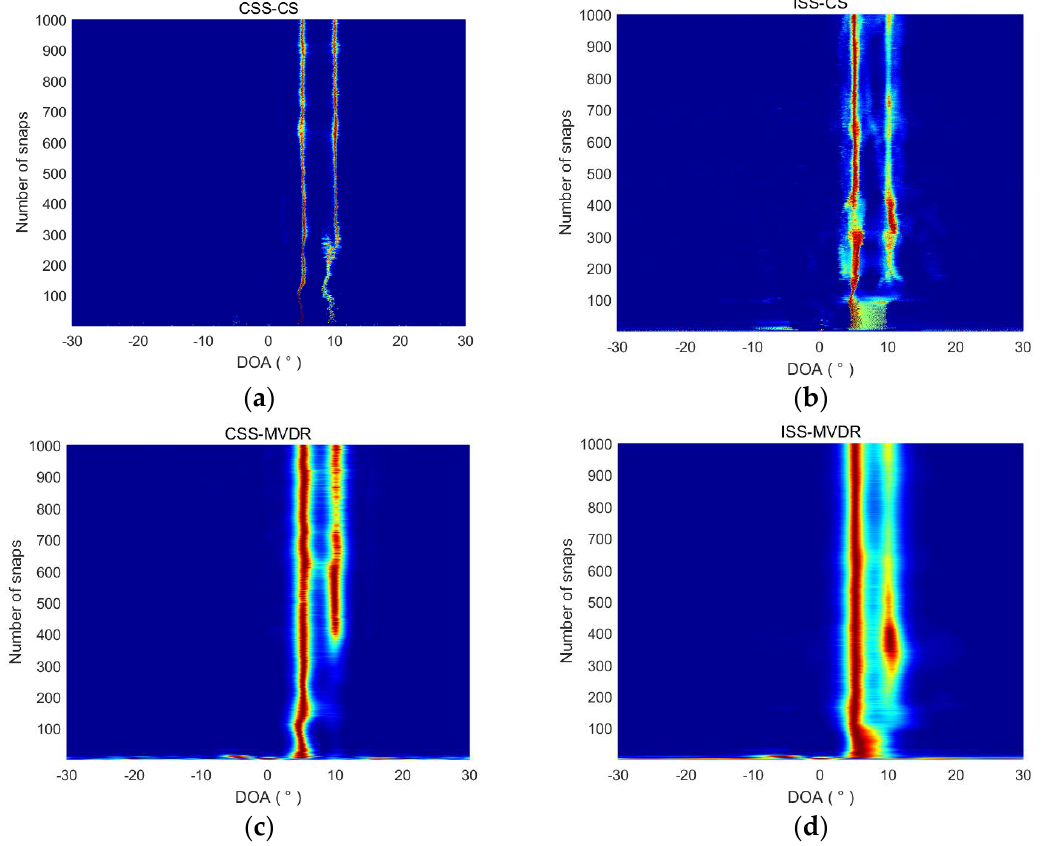
Figure 8. DOA estimation of the four methods under different snapshot numbers. ( a ) DOA estimation of CSS-CS under different snapshot numbers; ( b ) DOA estimation of ISS-CS under different snapshot numbers; ( c ) DOA estimation of CSS-MVDR under different snapshot numbers; ( d ) DOA estimation of ISS-MVDR under different snapshot numbers.